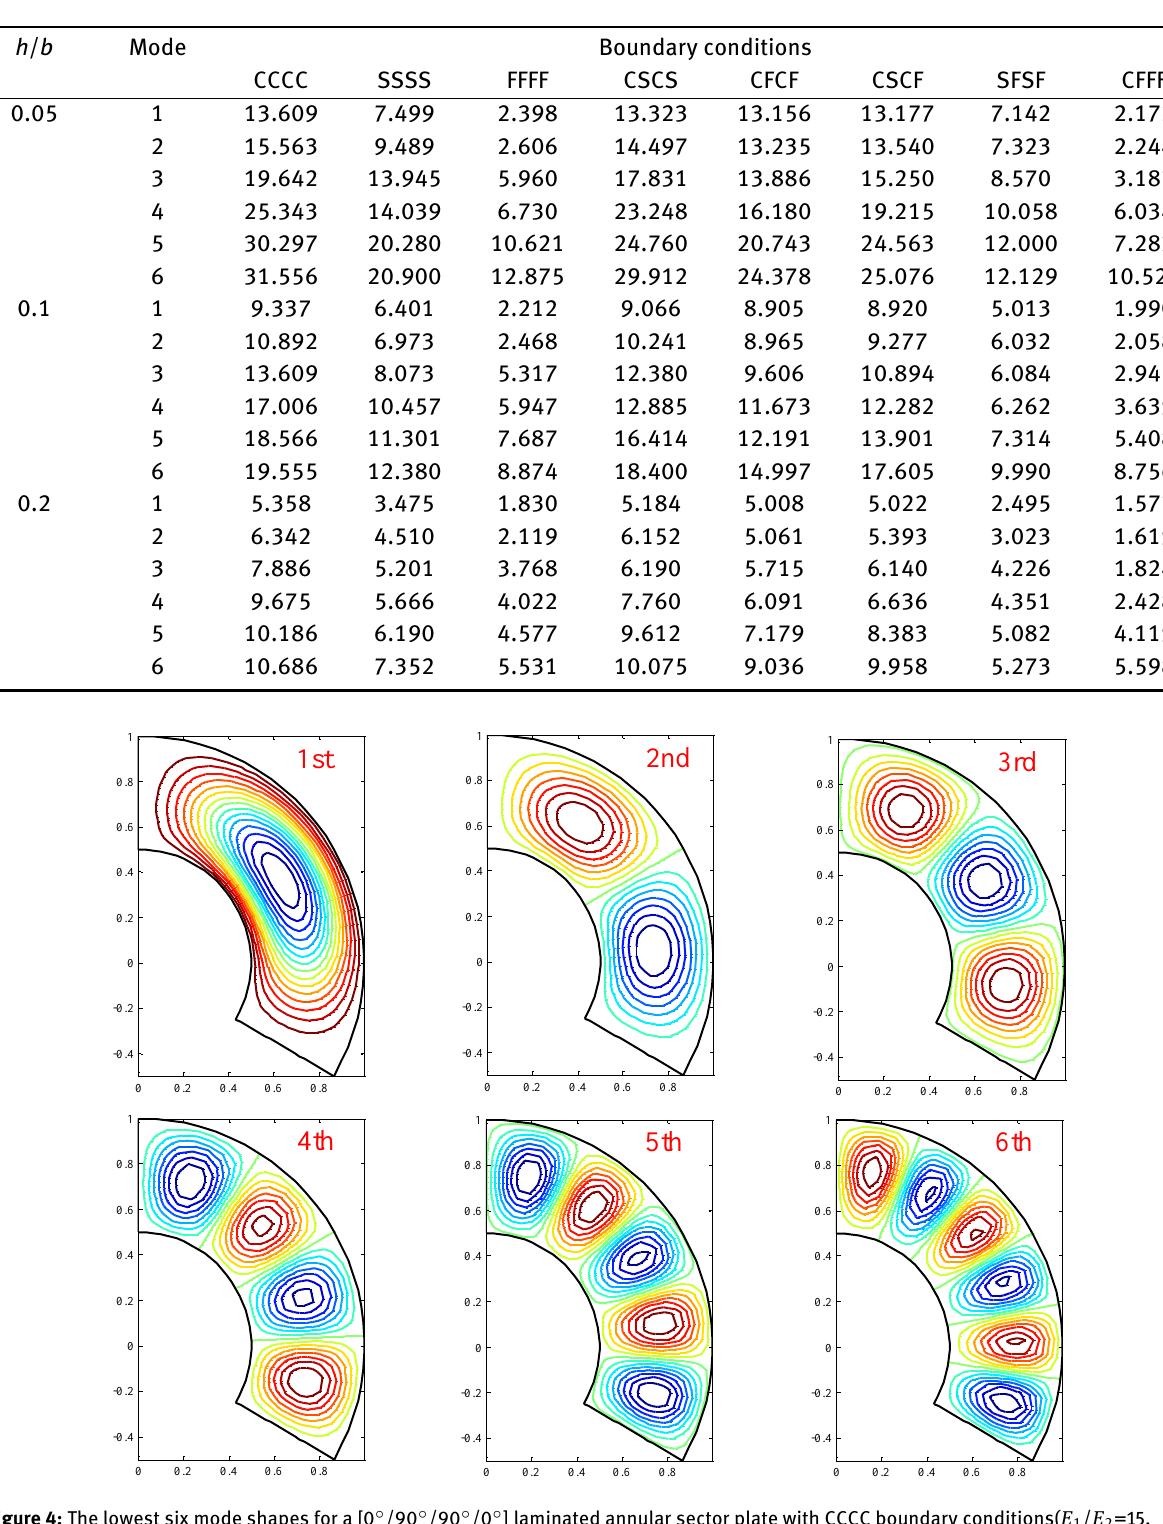
Figure 4: The lowest six mode shapes for a [0 ∘ /90 ∘ /90 ∘ /0 ∘ ] laminated annular sector plate with CCCC boundary conditions( E 1 / E 2 =15, a / b =0.5, h / b =0.1, ϕ =2 π